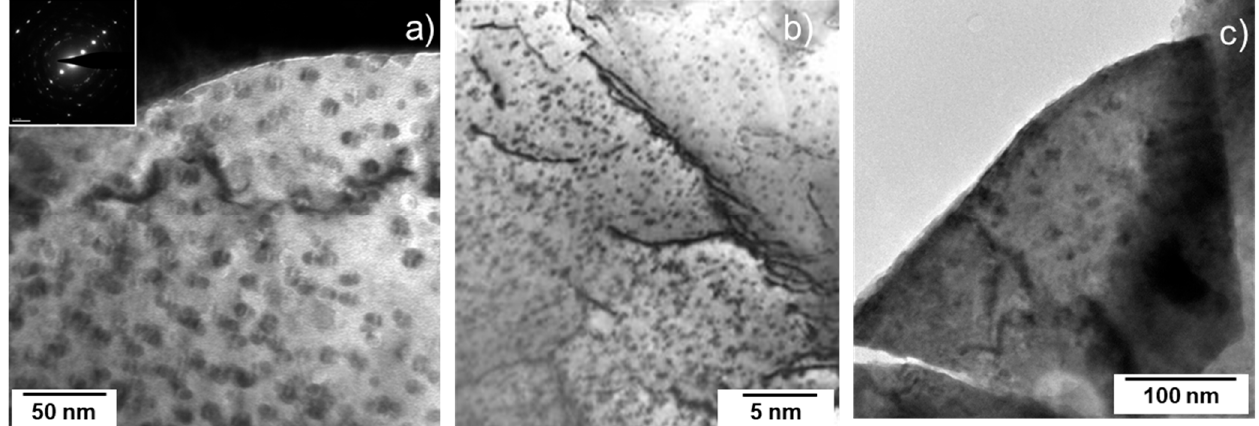
Figure 10. TEM bright field micrographs of UO 2 fuel irradiated at; ( a ) 70 GWd.t − 1 ; ( b ) 34 GWd.t − 1 , and ( c ) 58 GWd.t − 1 . For all samples, the cooling before examination led to the accumulation of approximately 0.1 dpa.